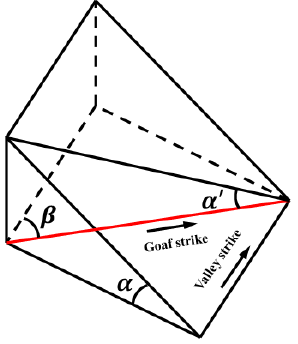
Figure 10. Spatial relationship between goaf strike and valley.